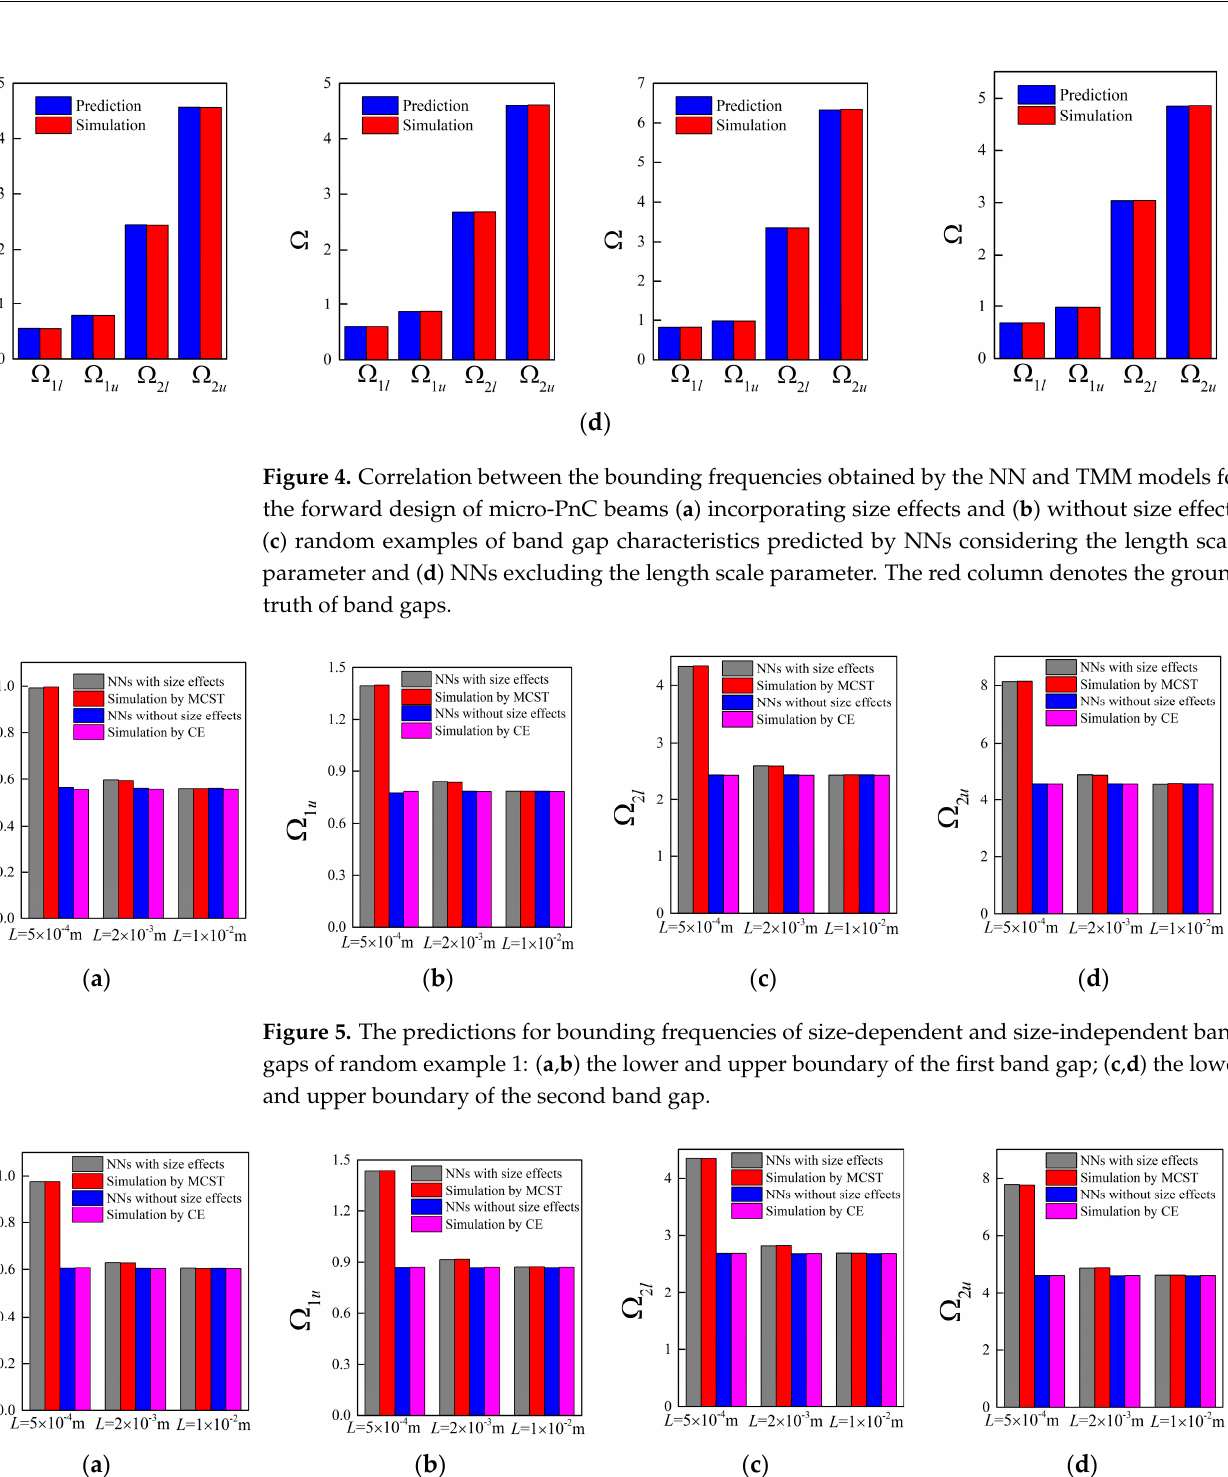
Figure 5. The predictions for bounding frequencies of size-dependent and size-independent band gaps of random example 1: ( a , b ) the lower and upper boundary of the first band gap; ( c , d ) the lower and upper boundary of the second band gap.